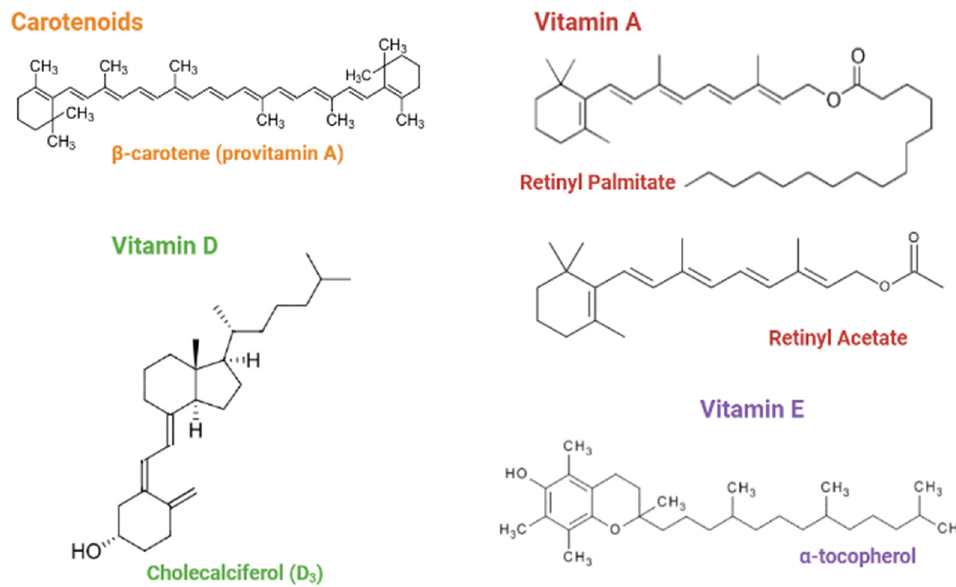
Figure 1. Chemical structures of the liposoluble vitamins discussed in this article.